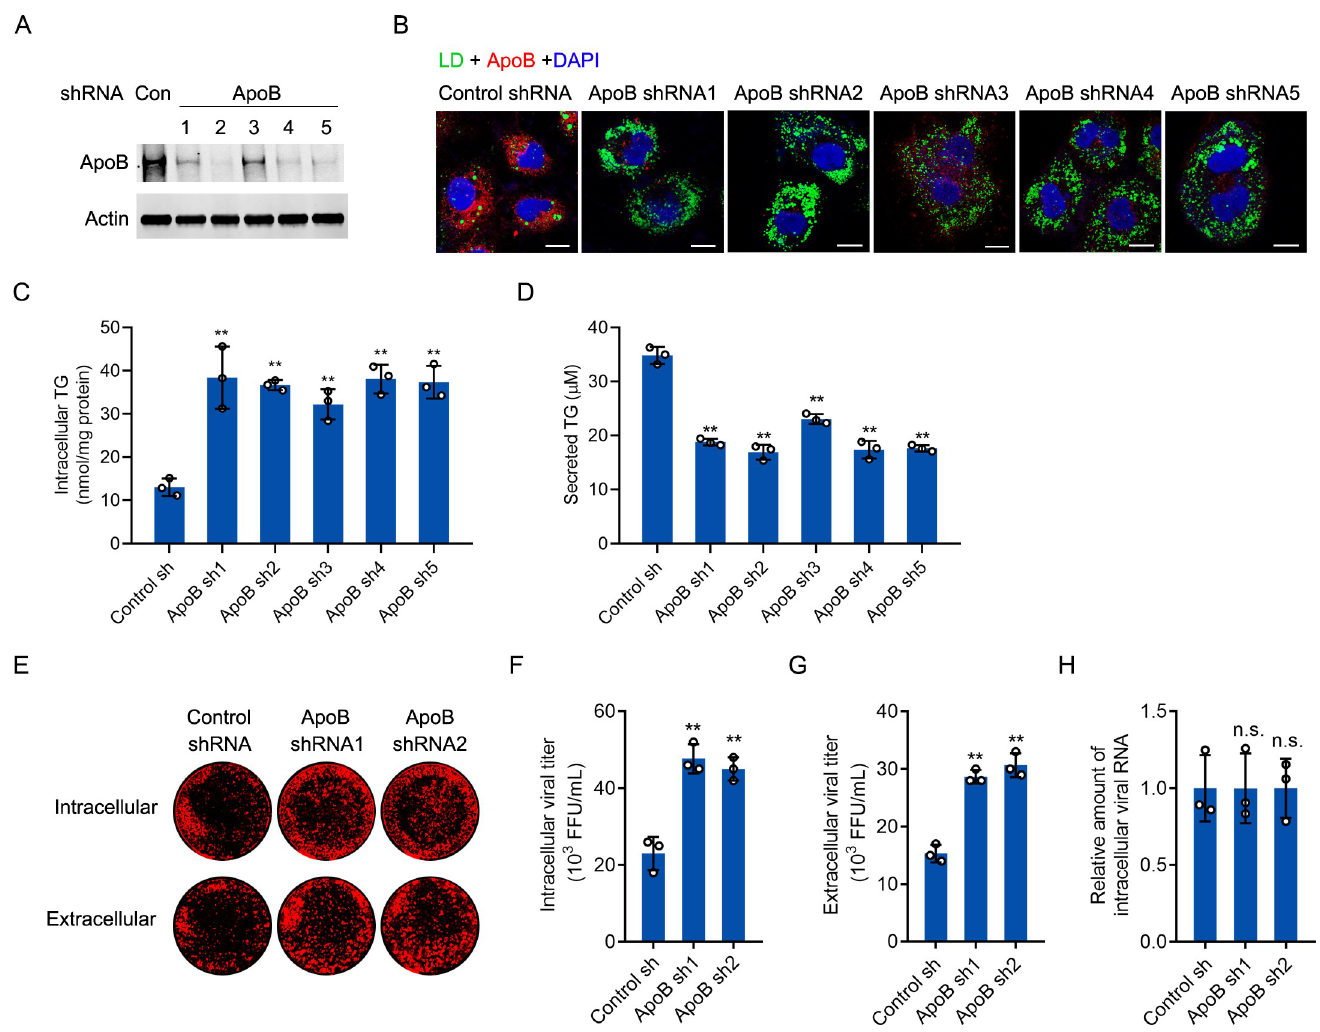
Fig 8. The knockdown of ApoB increased lipid accumulation and promoted HCV production. (A) Huh-7 cells were transduced with ApoB shRNAs. The protein level of ApoB was analyzed by western blotting. Actin was used as the loading control. (B) Huh-7 cells were transduced with ApoB shRNA1-shRNA5. Immunostaining was performed with an anti-ApoB antibody. LDs were stained with BODIPY 493/503. Nuclei were stained with DAPI. Fluorescence signals were visualized by laser confocal microscopy. Scale bars, 10 μ M. (C and D) The intracellular and secreted TG concentrations in cells in B were analyzed using a TG quantification kit. TG, triglyceride. (E) Huh-7 cells were transduced with ApoB shRNA1 or shRNA2 for 2 days prior to HCV infection (MOI = 1) for 4 days. Cell lysates and culture supernatants were collected to infect Huh-7 cells. In-cell western blot analysis was performed with an anti-core antibody. Cells were further labeled with IRDye 800-conjugated secondary antibodies and scanned with an Odyssey infrared imaging system. (F and G) Viral titration was performed by immunostaining. (H) The intracellular HCV RNA level was analyzed by real-time PCR. GAPDH was used as the internal control. The statistical significance was determined by unpaired two-tailed Student’s t -tests. The data are presented as the means ± SDs of n = 3 biological repeats. n.s., not significant. �� P <